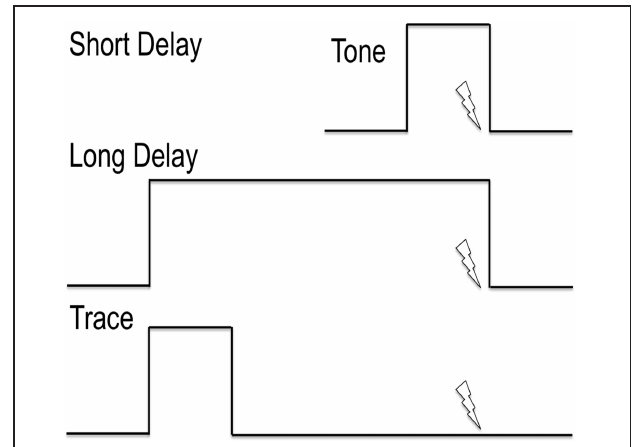
FIGURE 4 | Explanation of cued delay conditioning vs. cued trace conditioning. The lines indicate the timing of the tone as conditioned stimulus. The lightning bolt indicates the timing of the foot shock or other aversive unconditioned stimulus. Delay conditioning is independent of the hippocampus, while trace conditioning requires hippocampal